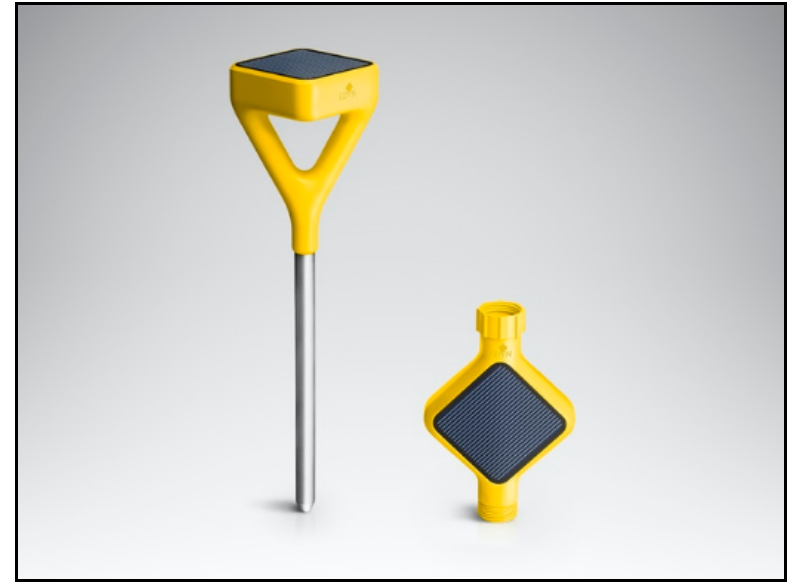
Figure 5. Edyn Garden Sensor and water valve